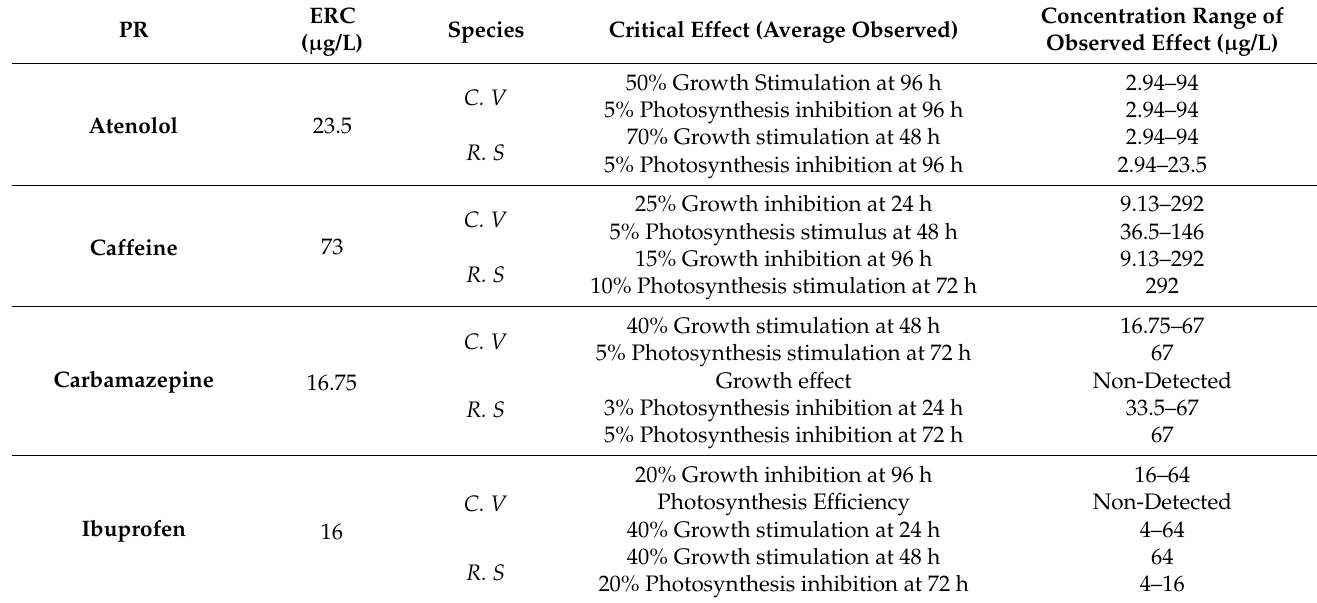
Table 2. Pharmaceutical concentrations and their effect on C. vulgaris and R. subcapitata